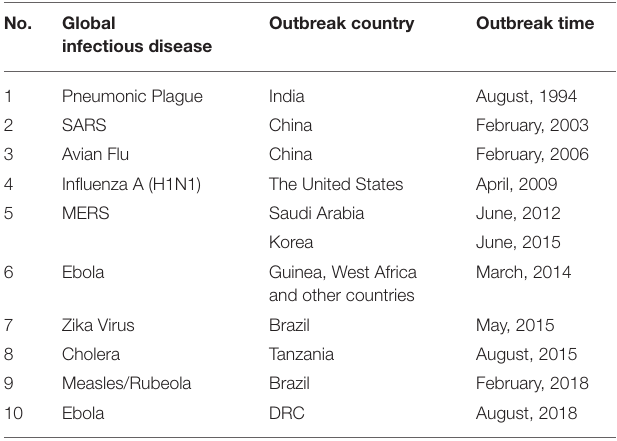
TABLE 1 | Global timeline of the top 10 major infectious disease related